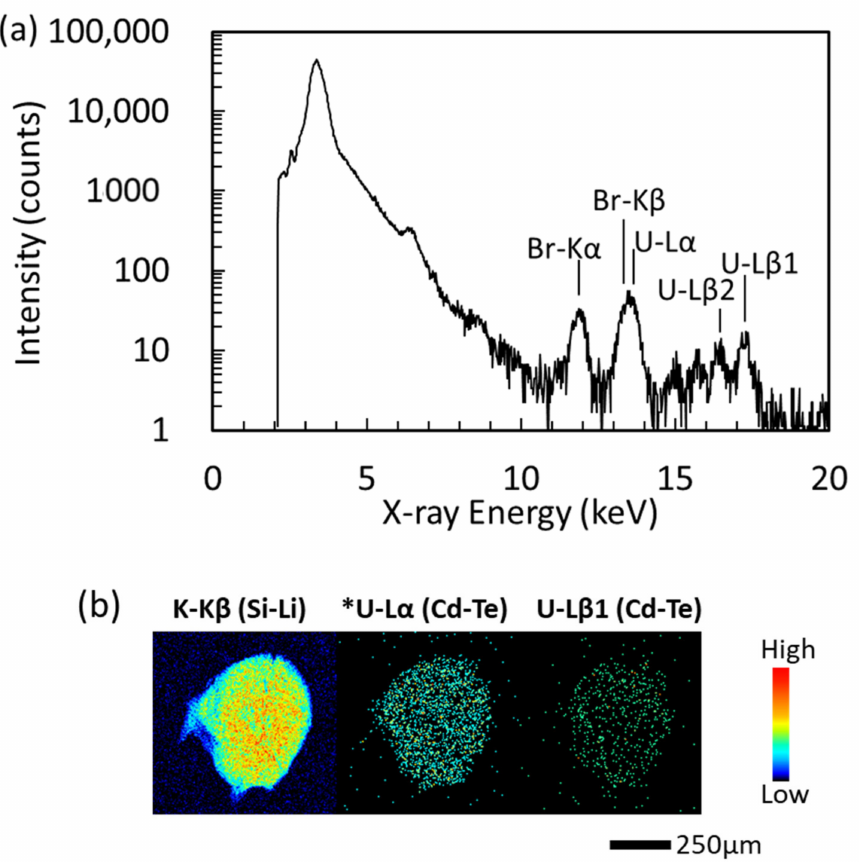
Figure 5. ( a ) µ -PIXE spectra of specimens prepared using 1 µ L droplet of mixed solutions of urine treated with five-fold HNO 3 . The urine was collected for five hours after 4 mg/kg U administration to rats. ( b ) X-ray imaging of K-K α line by Si(Li), U-L α , and U-L β 1 lines by CdTe detector. *Imaging of U-L α line expresses sum of the counts at U-L α and Br-K β